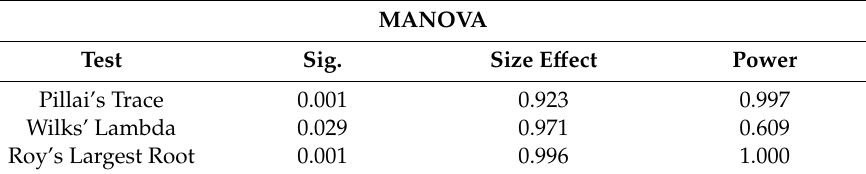
Table 5. Results of multivariate analysis of variance (MANOVA).